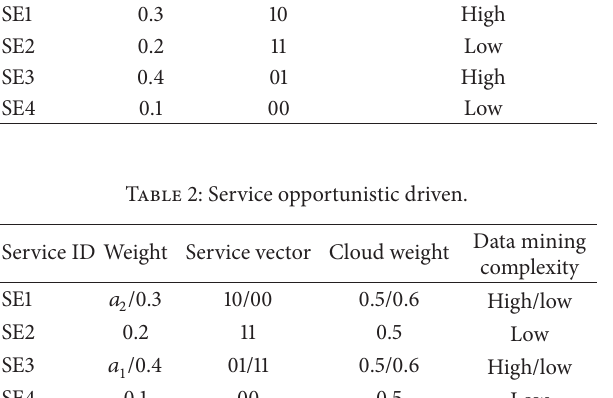
Algorithm 1. Construction of cloud platform is as